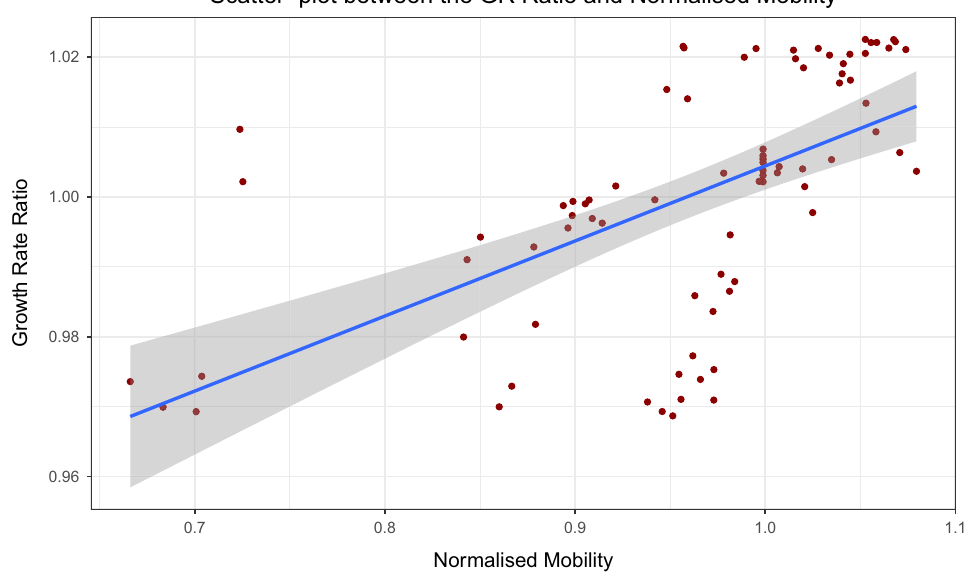
Figure 11. Scatter-plot between the growth rate ratio in the number of cases and the normalised mobility: there appears to be some relationship between an increase in mobility and an increase in the growth rate ratio for the optimal lag of 21